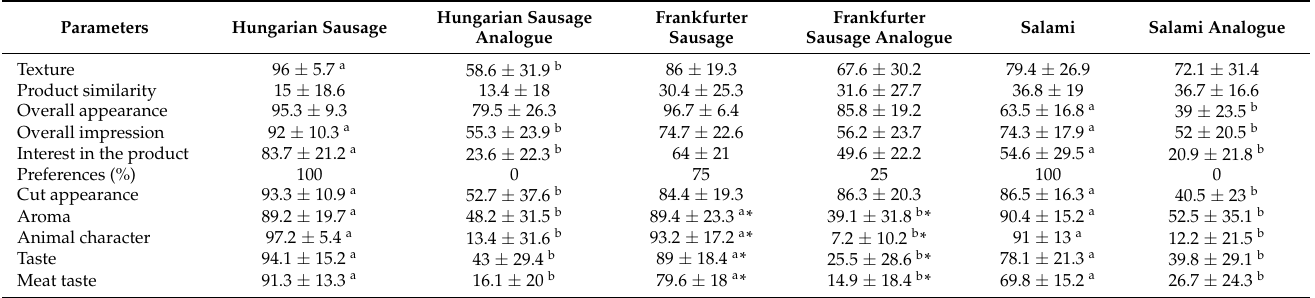
Table 4. Sensorial attributes of Hungarian sausage, Frankfurters sausage, salami and their analogues